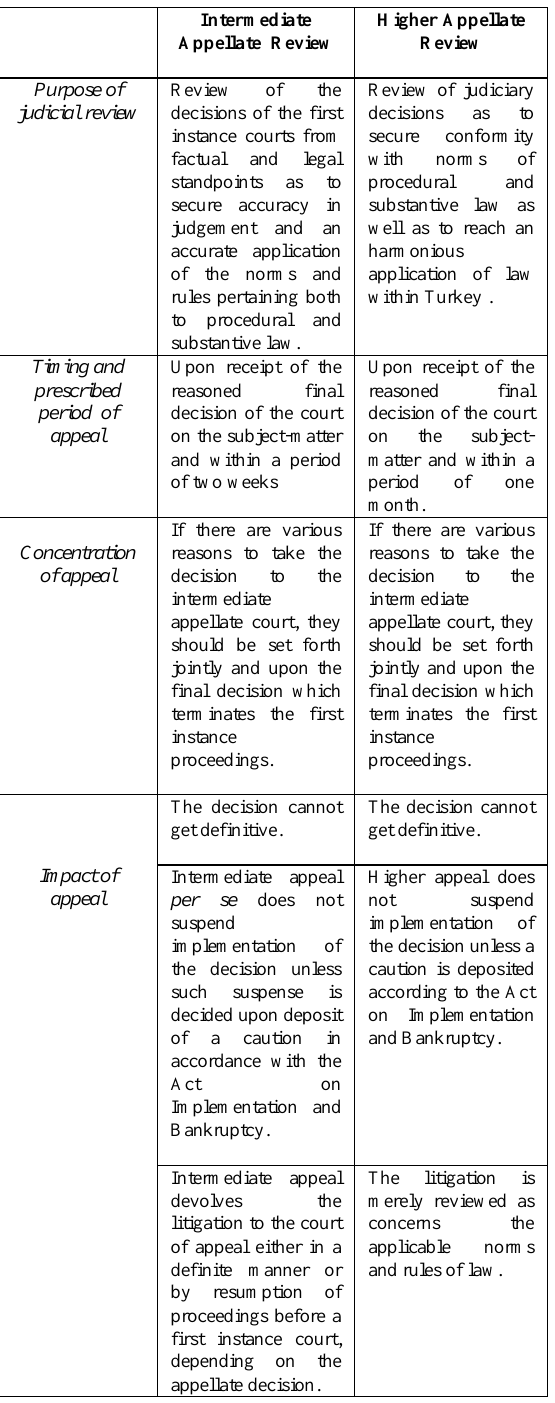
Table 1: Intermediate Appellate Review and